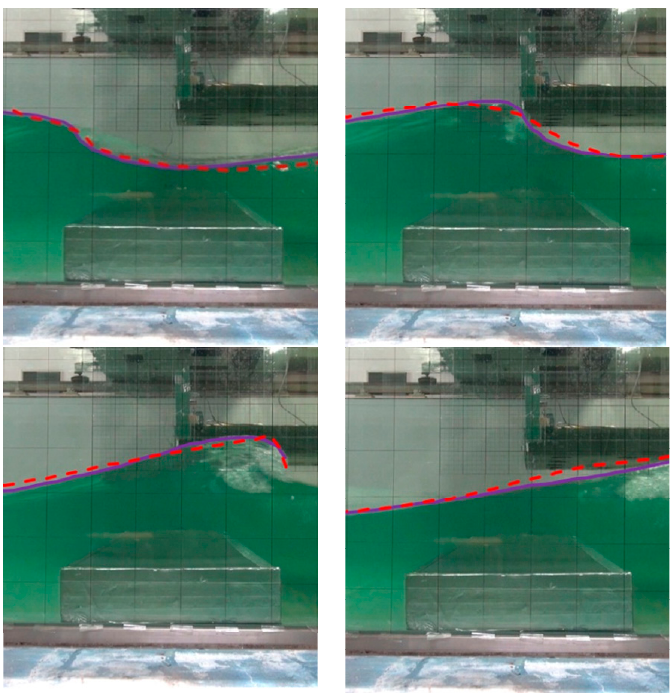
Figure 14. Visual comparison of wave-surface deformation at t = 35.0 s, 35.2 s, 35.4 s, 35.6 s.